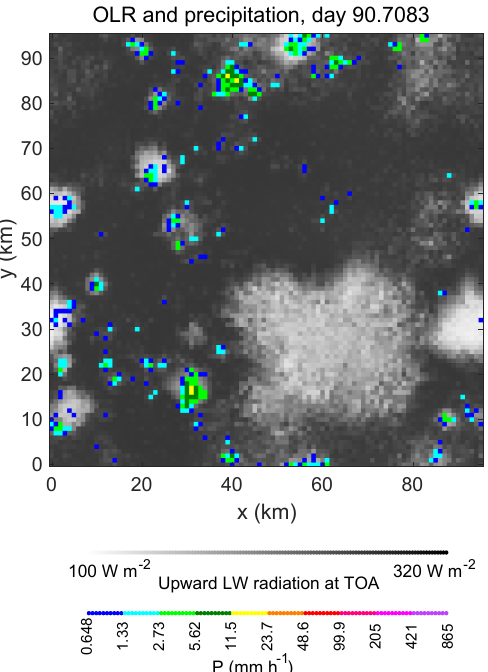
Figure 3. Hourly-average OLR (gray shading) and precipitation (color shading) in small-domain System for Atmospheric Model- ing (SAM) simulation at T s =